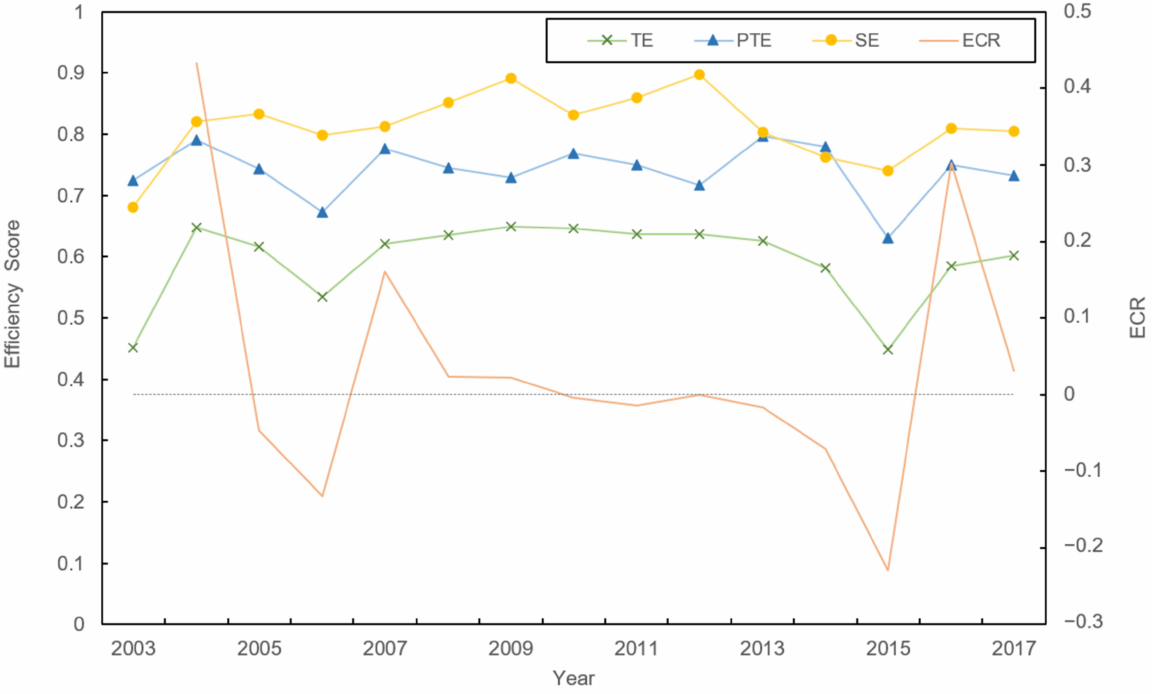
Figure 3. Evolution trend of NSAs’ tourism efficiency in China from 2003 to